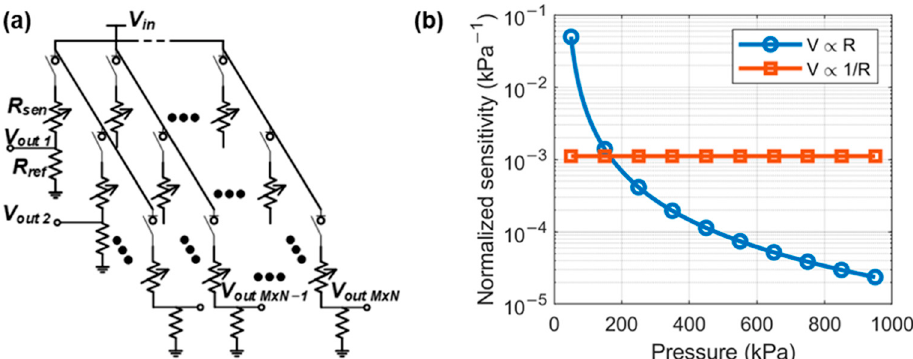
Figure 3. ( a ) Circuit diagram of the multi-channel resistance-to-voltage converter. ( b ) Sensitivity curves of the conventional linear and proposed nonlinear signal readout.